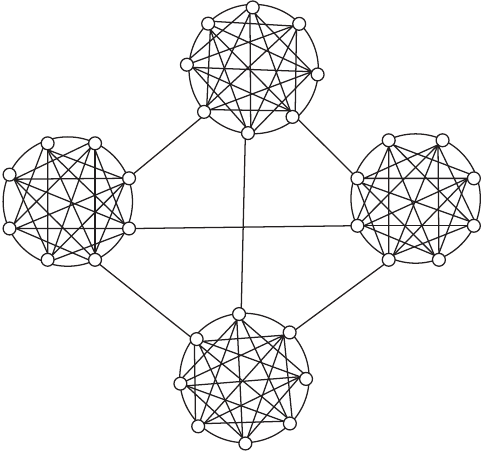
Figure 5. Four Clusters topology.